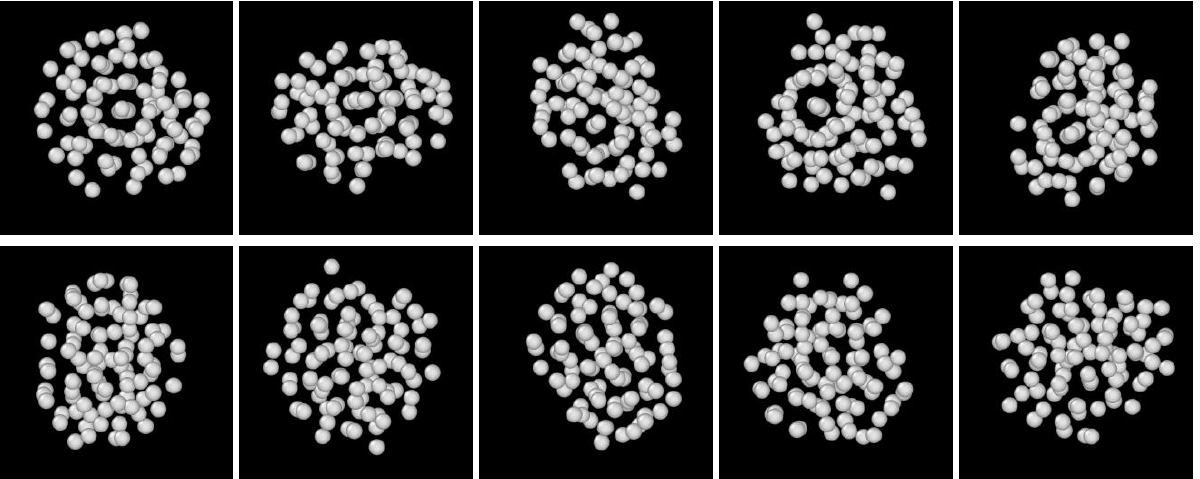
Figure 7. Snapshots of a solid cluster forming in an sHPFC simulation performed under the same conditions as the simulation shown in Figure 5. In the left three panels, small spheres are used to indicate the position of the density peaks, which allows us to see the presence of an ordered but non-crystalline initial structure. On the right atom-size spheres are displayed. The snapshots were taken at dimensionless times t = 450, 500, 600, 800, and 950. The same coloring is used as in Figure 3. A fraction of a 512 3 simulation is shown.